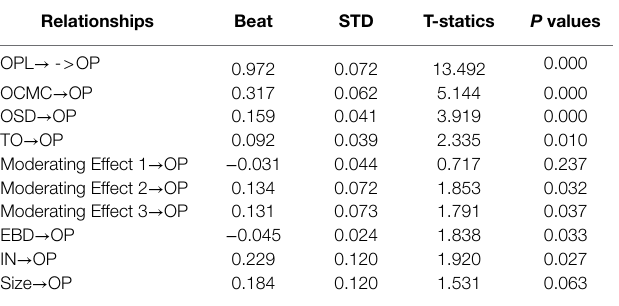
TABLE 3 | Structural model.